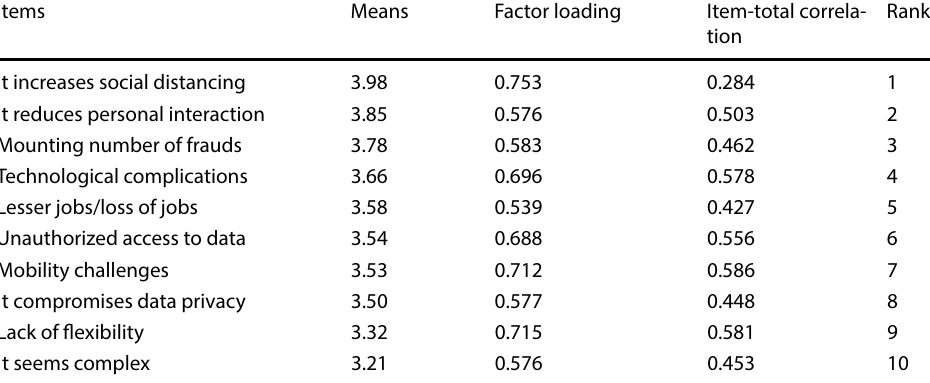
Table 4 Participants’ perceptions about the challenges faced while using IoT